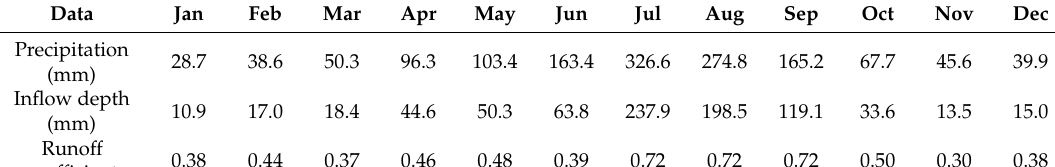
Figure 1. Location of the Boryeong Dam watershed and its elevation. Table 1. Monthly average precipitation, reservoir inflow depth and runo ff coe ffi cient (1998–2016).